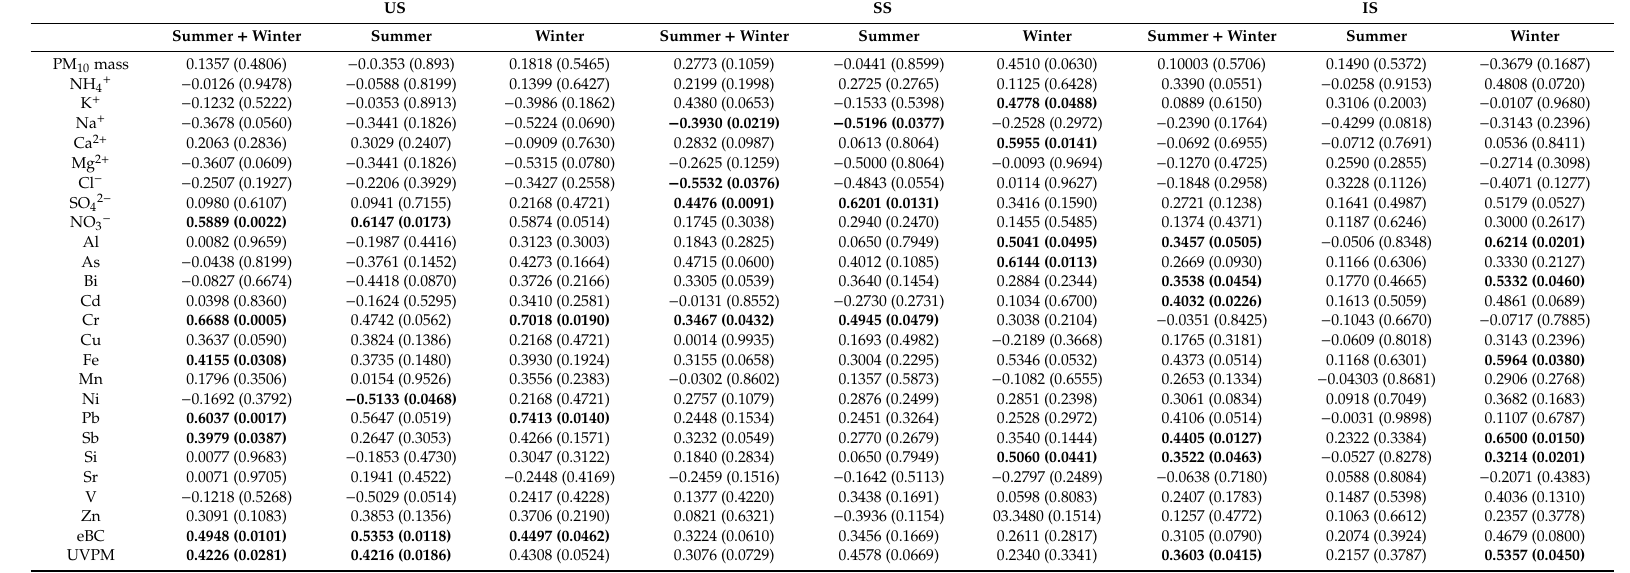
Table 3. Spearman rank correlation coe ffi cients and p -values (in brackets) for PHg and major ions, metals, eBC and UVPM at urban site US (whole period, summer season, winter season), suburban site SS (whole period, summer season, winter season) and industrial site IS (whole period, summer season, winter season) at the probability of 95%. Bolded numbers means statistically significant